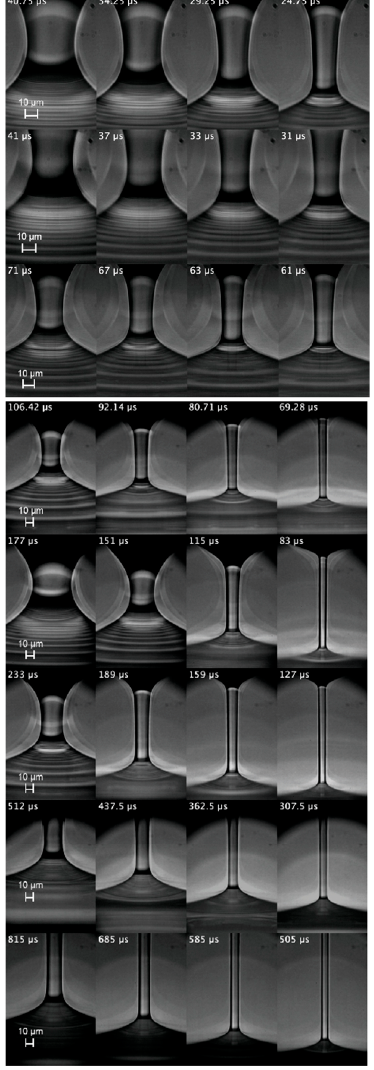
Figure 3 Figure 3. (From top to bottom) Images of the filament thinning over the elasto-capillary regime of PVP0.07, PVP0.1, PVP0.2, PVP0.4, PVP0.6, PVP1, PVP2 and PVP3. The labels indicate the time to the pinching. The white line separates the discarded realizations from those were the linear elasto-capillary regime was